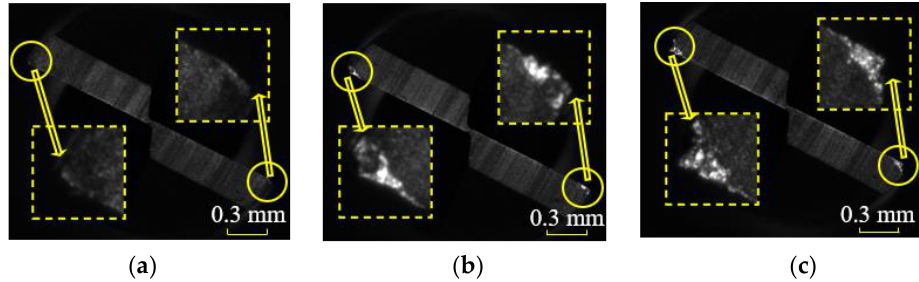
Figure 3. Tool cutting sequence. ( a ) Original tool; ( b ) 15th cutting tool; ( c ) 29th cutting tool.